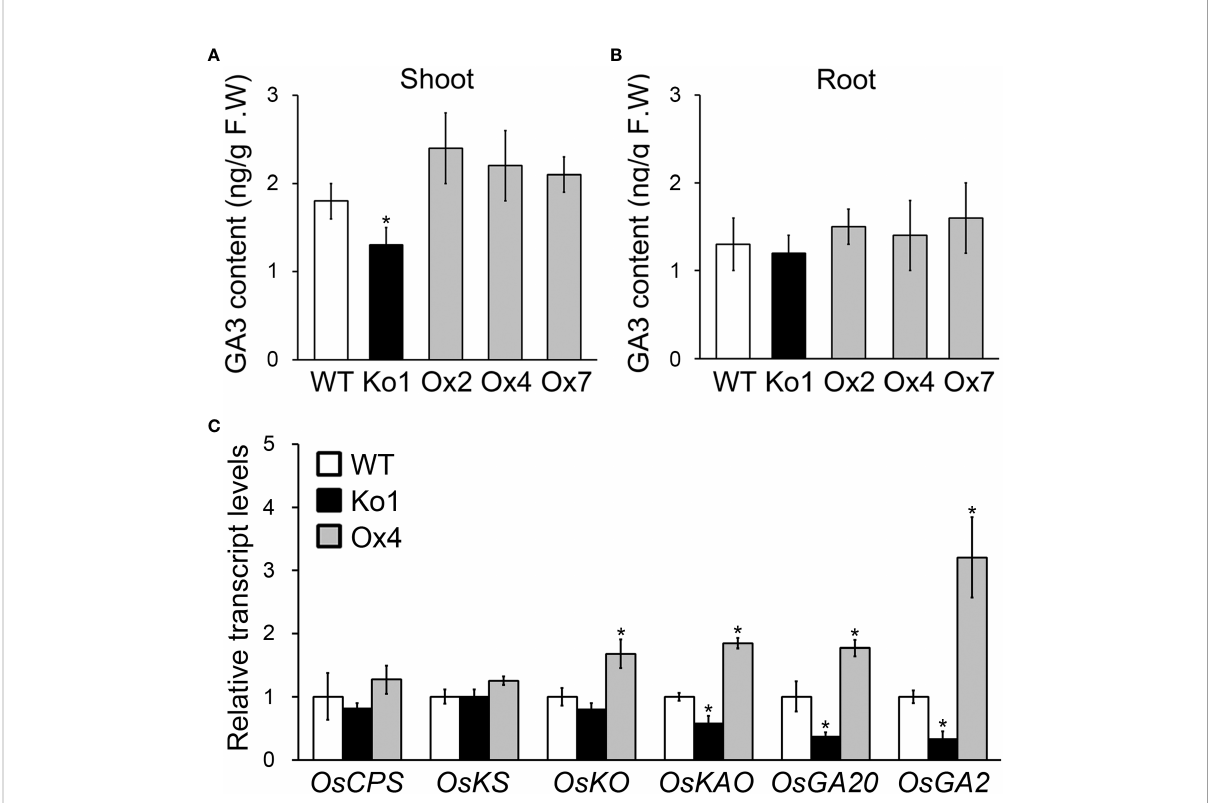
FIGURE 3 Analysis of GA3 concentrations and GA biosynthesis genes expression in osgasd knockout mutant and OsGASD -overexpressing transgenic plants. (A, B) GA3 concentrations were measured in the shoots (A) and roots (B) of Ko, Ox and WT plants grown on MS media for 30 days. (C) RT-qPCR analysis shows changes in transcriptional expression levels in shoot of Ko, Ox and WT plants. CPS, Copalyl diphosphate synthase; KS, ent-kaurene synthase; KO, ent- kaurene oxidase; KAO, ent- kaurenoic acid hydroxylase; GA20, GA 20 oxidase; GA2, GA 2 oxidase. Error bars indicate SD. OsActin1 (Os03g0718100) was used as an internal control and relative expression levels are shown in fold values. Asterisks indicate statistically signi fi cant differences between the corresponding samples and their control (p-value<0.1, Student ’ s